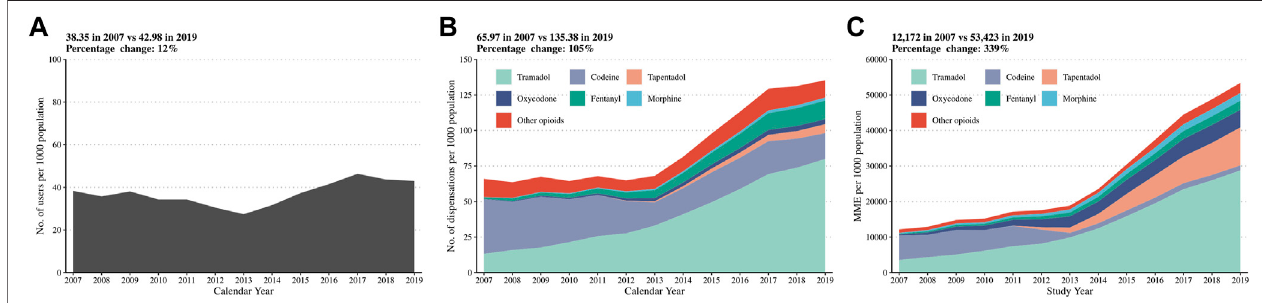
FIGURE 1 | Number of opioid users (A) , number of opioid dispensations (B) , and oral MME (C) per 1,000 population from 2007 to 2019 in the overall population. MME: Morphine milligram equivalents. Other opioids included dihydrocodeine [N02AA08], hydromorphone [N02AA03], dextropropoxyphene